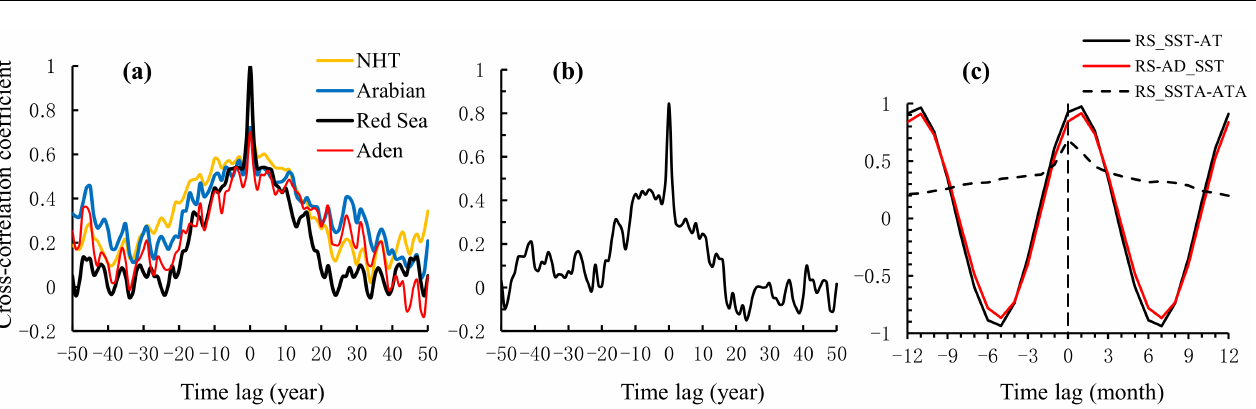
Figure 5. Correlation analysis for Red Sea SST. Cross-correlation coefficients between annual SST anomalies of Red Sea and those of adjacent seas and NHT ( a ) and Red Sea air temperature anoma- lies ( b ); ( c ) cross-correlation coefficients between Red Sea SST and air temperature (RS_SST-AT), Red Sea SST anomalies and air temperature anomalies (RS_SSTA-ATA), as well as Red Sea SST and Gulf of Aden SST (RS_AD-SST). A positive lag represents SST/SSTA series lagging behind other